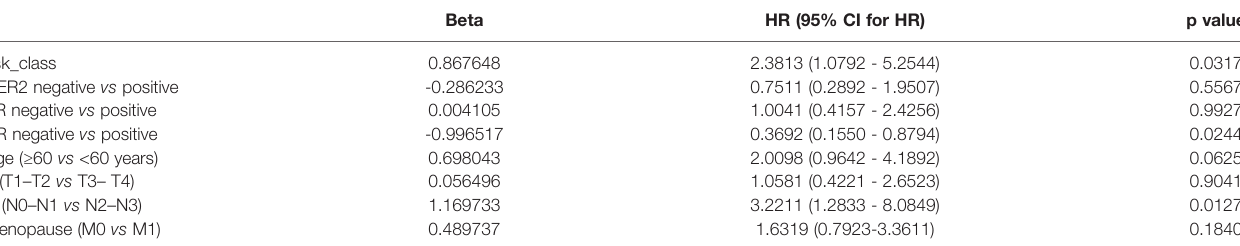
TABLE 5 | Multivariate COX regression analysis.